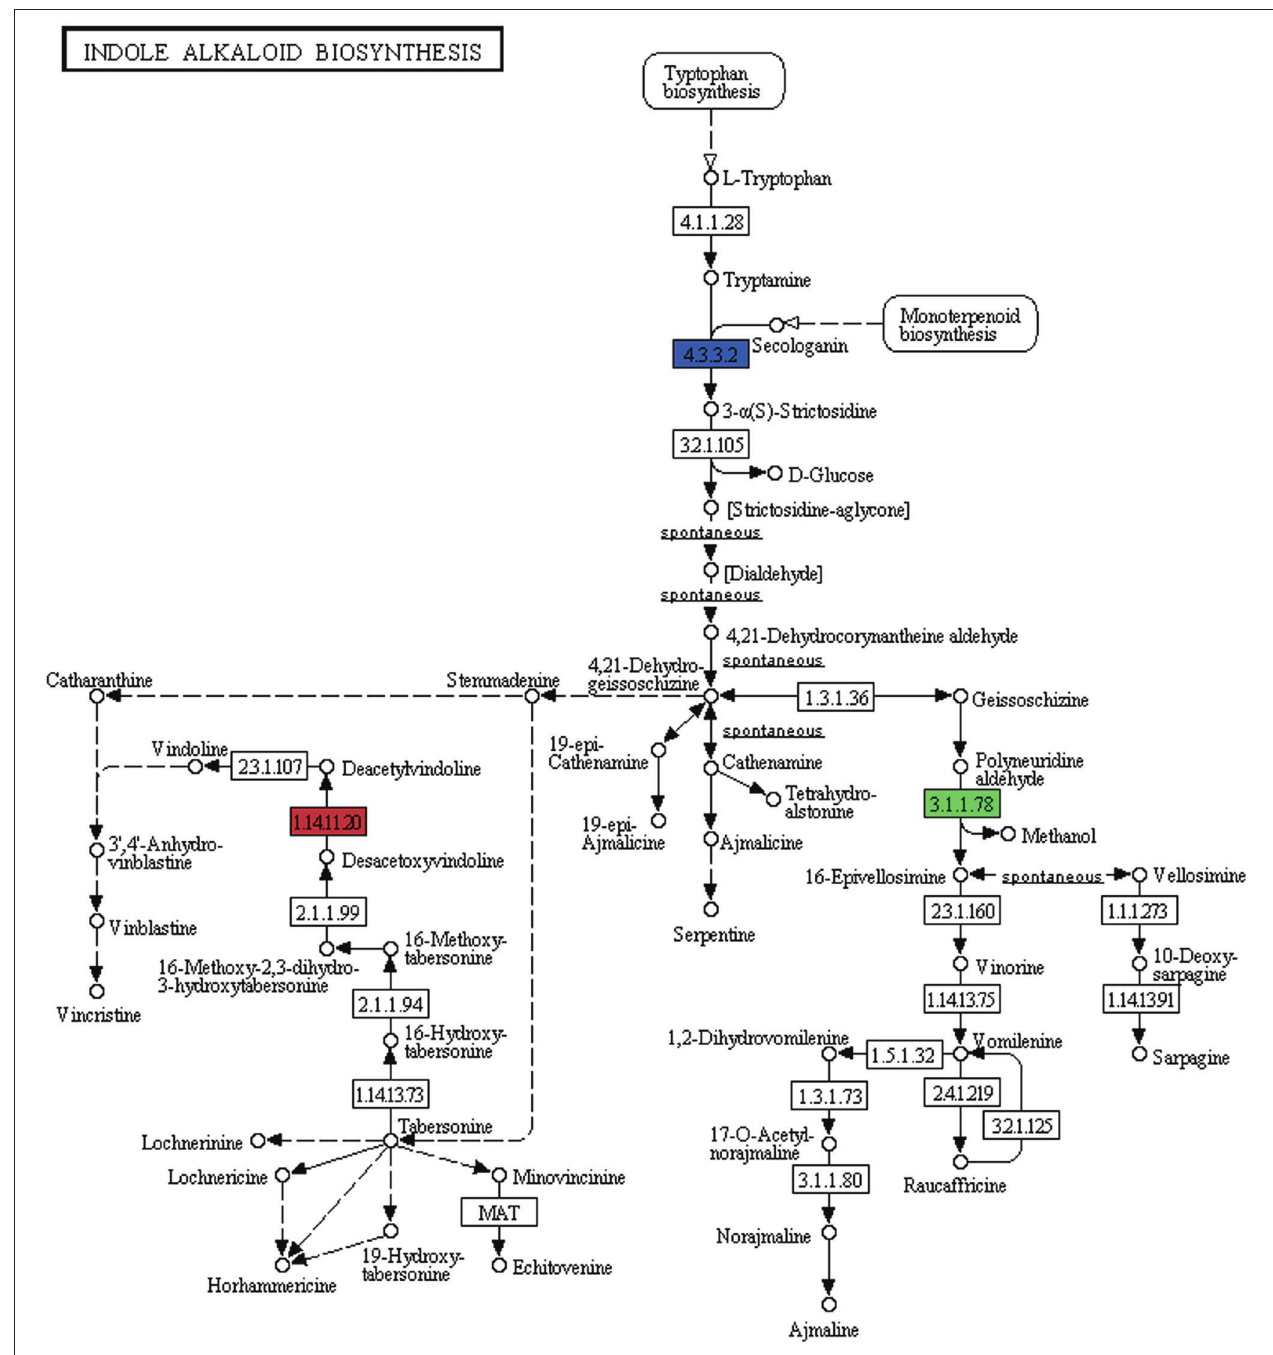
FIGURE 9 | Indole alkaloid biosynthetic pathway genes found in P. amarus leaf transcriptome are depicted by the different colored ECs (one color for each EC).